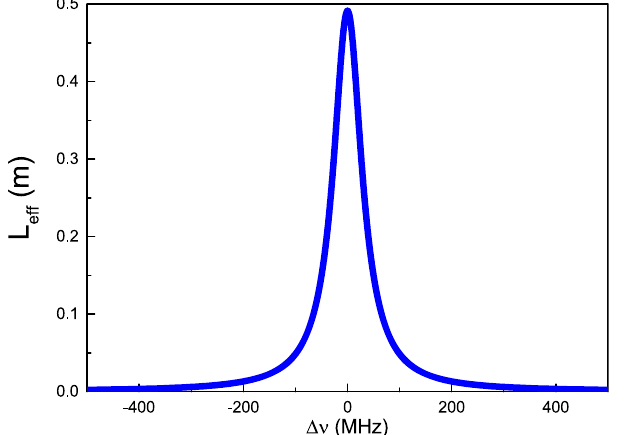
Figure 5. Effective cavity length of phase-shifted grating in PSFBG-F-FBG resonator, plotted versus the frequency detuning Δ v = C / λ − C / λ B